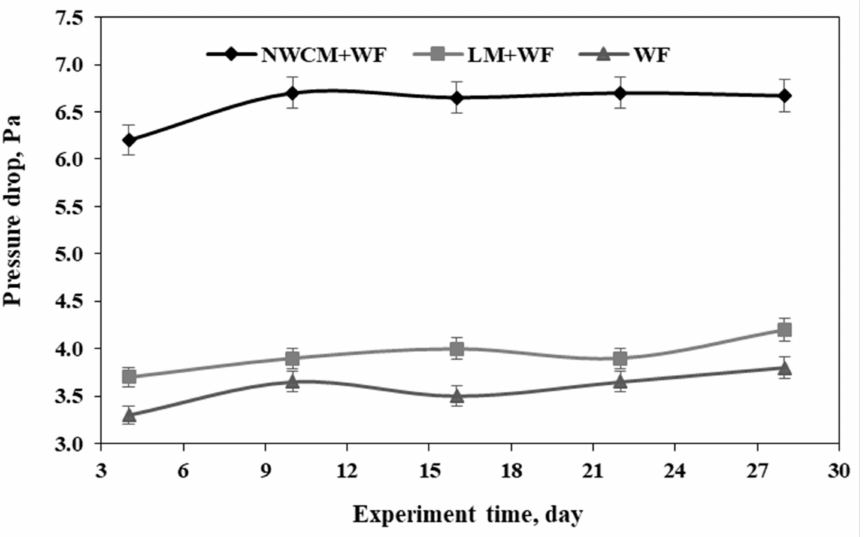
Figure 4. The pressure drop (Pa) in the biofilter with different packing materials. NWCM + WF: non- woven caulking material and wood fiber, LM + WF: linen material and wood fiber, WF: wood